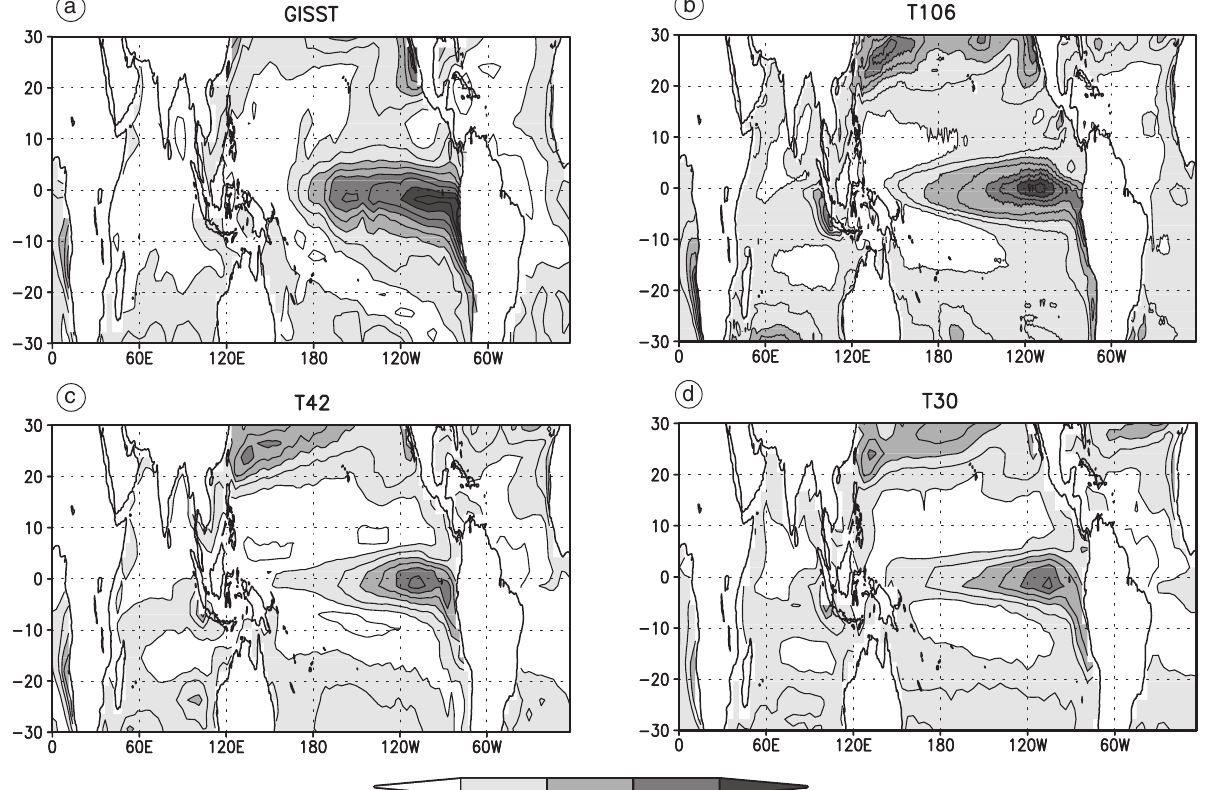
Fig. 10a-d. Standard deviation of the SST field in the Tropics. Panel a): as derived from the GISST data set; panel b): T106 experiment; panel c): T42 experiment; panel d): T30 experiment. Contour line interval is 0.1 ° C. Values larger than 0.4 ° C are shaded; the shaded contour interval is 0.2 °